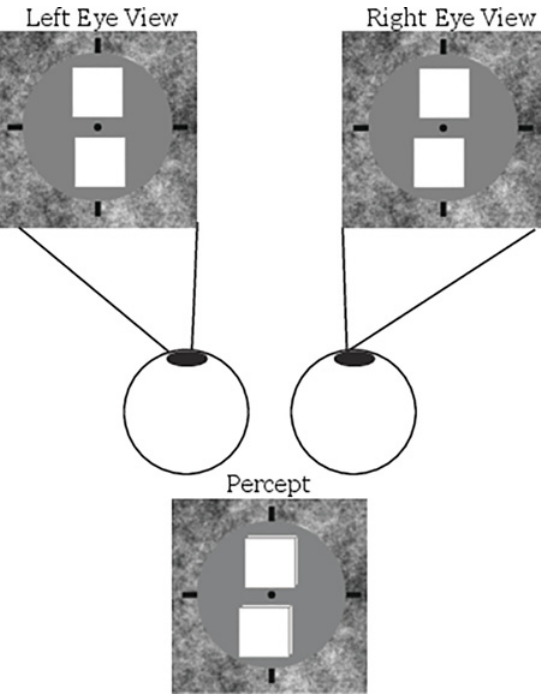
Fig 2. Example display (vertically oriented stimuli). On each trial participants were presented with two white squares offset from one another in both the z- and x-dimensions. Participants performing the vernier acuity task were asked to judge which of the two squares was further to the left, while participants performing the stereo acuity task were asked to judge which of the two squares was closer in depth. Again , note that the actual stimuli were flat squares – they are presented as 3D boxes here for demonstration purposes